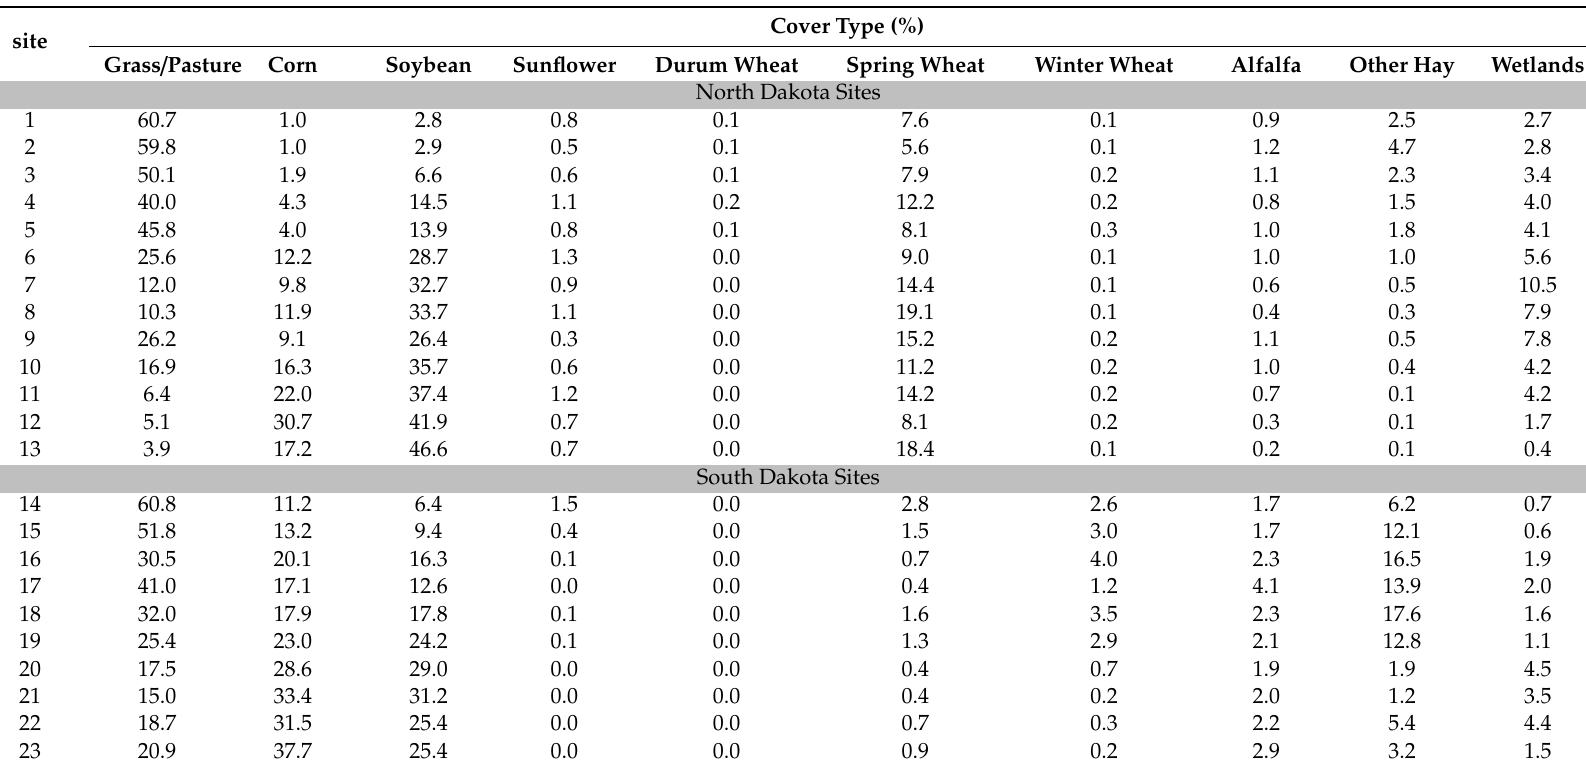
Table 1. The temporal average proportion of cover type for the 13 AMSR-pixels study sites transect in ND (2003–2016) and 10 sites in SD (2006–2016). Note the general spatial trend of crop versus grassland / pasture covers in both